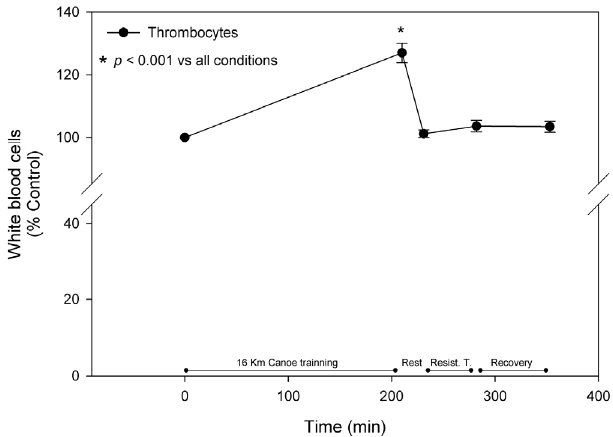
Figure 5. Thrombocytes. Thrombocyte levels were measured as described in materials and methods and are represented as mean ± standard error of percentage values against control. * Indicates statistical difference against any other condition ( p < 0.05).